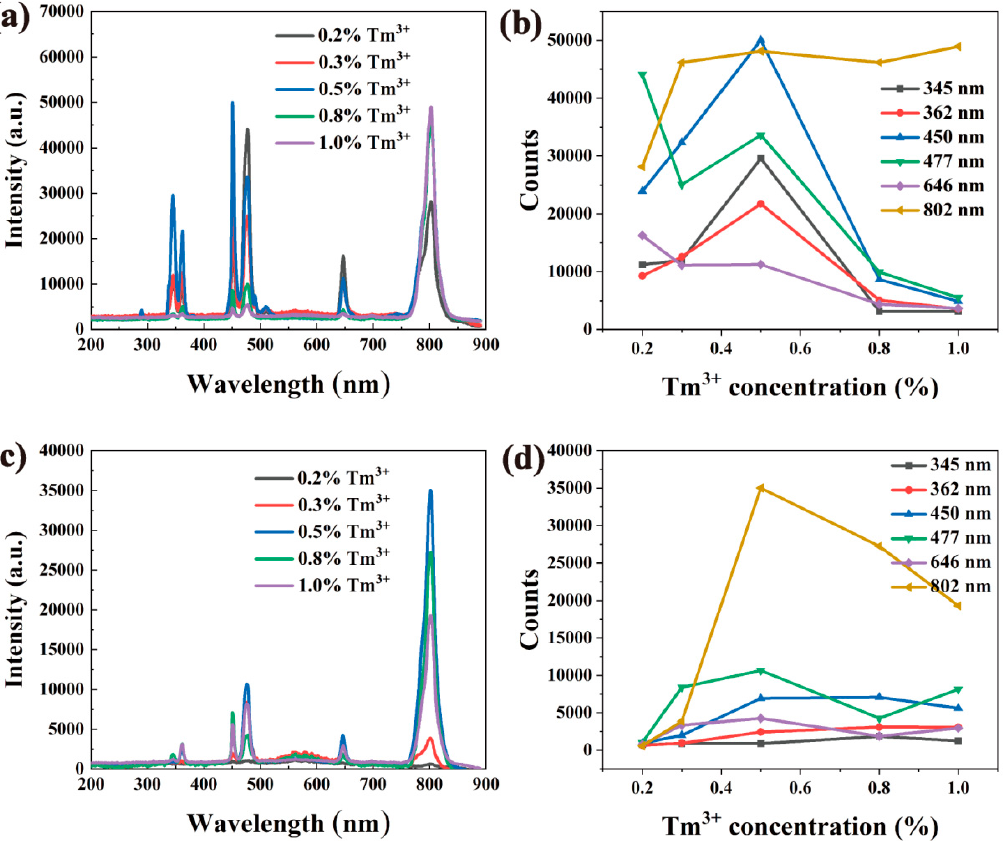
Figure 7. Fluorescence spectra of NaYF 4 : Yb 3+ , Tm 3+ and NaGdF 4 : Yb 3+ , Tm 3+ with different Tm 3+ doping ratios. ( a ) Fluorescence spectra of NaYF 4 :20%Yb 3+ , x%Tm 3+ (x = 0.2, 0.3, 0.5, 0.8, 1.0) at 980 nm excitation. ( b ) NaYF 4 : Yb 3+ with different Tm 3+ doping ratios, the relationship between the maximum intensity of the luminescence peak corresponding to Tm 3+ and the concentration change. ( c ) Fluorescence spectra of NaGdF 4 :20%Yb 3+ , x%Tm 3+ (x = 0.2, 0.3, 0.5, 0.8, 1.0 at 980 nm excitation). ( d ) The corresponding doping ratios of NaGdF 4 : Yb 3+ and Tm 3+ with different Tm 3+ doping ratios.